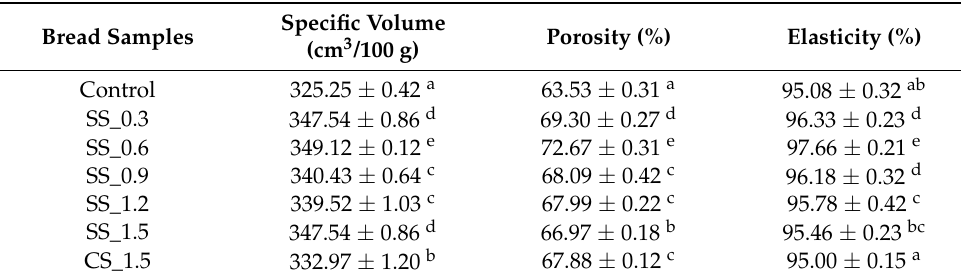
Table 5. Physical characteristics of the bread samples with different levels of sea salt with low sodium content (SS) additions.